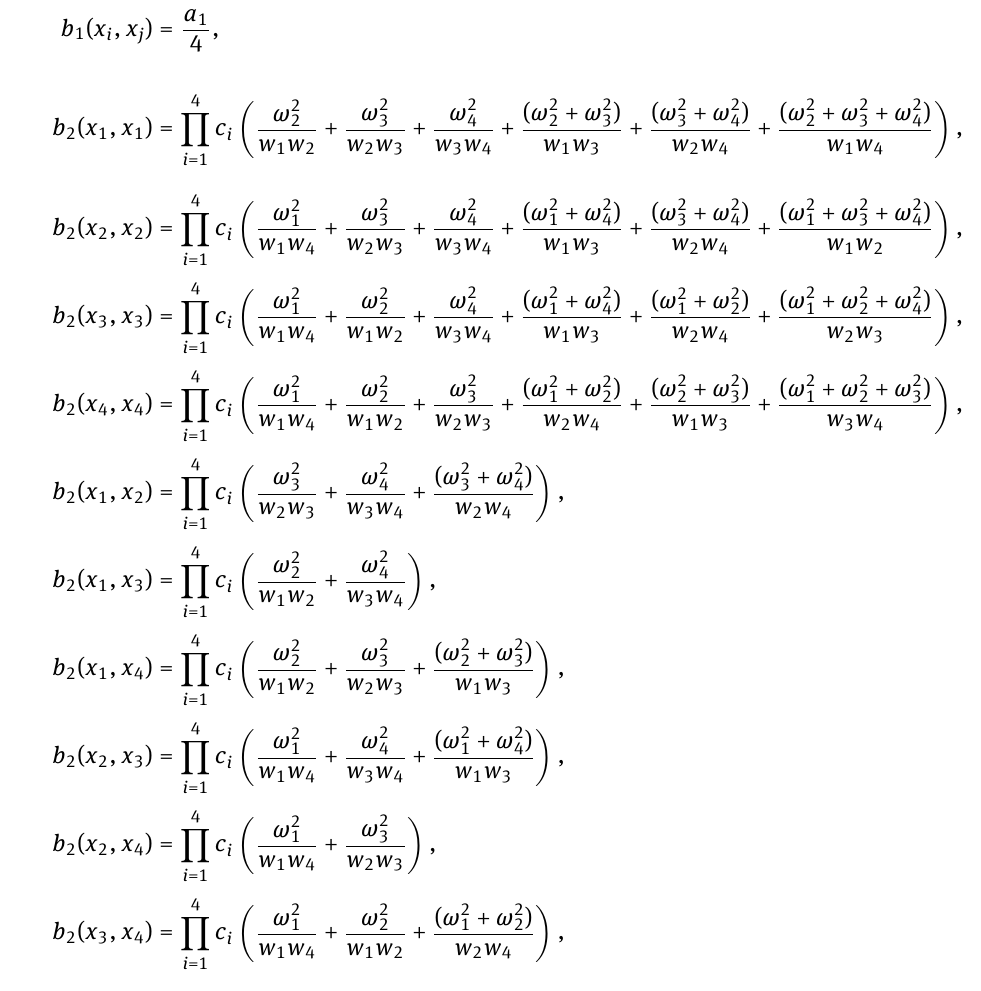
To compute the coefficient b k ( x i , x j ) it is enough to count the k -rooted forests displayed at Figures 11-13 with x i as a root and x j at the same component as x i